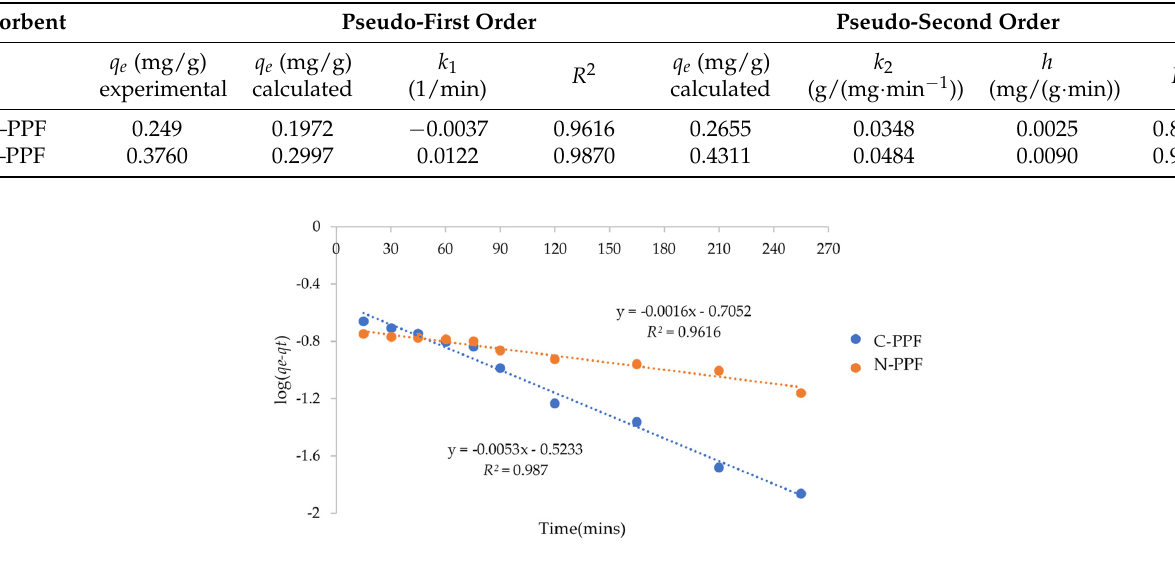
Figure 14. Pseudo–first–order model for Fe(III) adsorption of C–PPF and N–PPF.